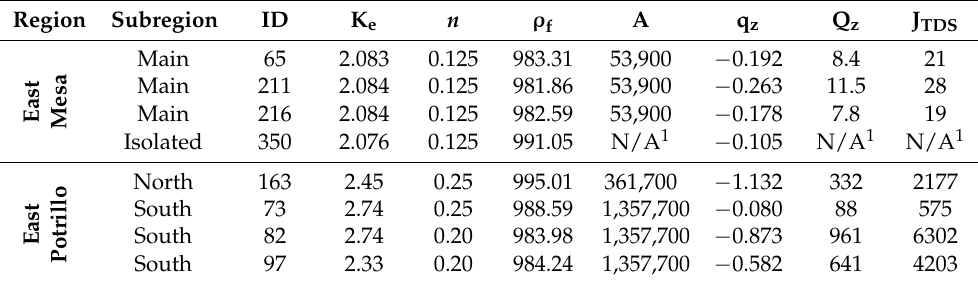
Table 1. Summary of flux estimates and input parameters used in modeling. Fluid specific heat was specified to be 4180 joules per kilogram per degree Celsius at all locations in the modeling. Modeled values for the thickness over which temperature data were analyzed (L) and best-fit Peclet numbers (Pe) are provided in Figure 6. Salinities of 1800 mg/L and 4823 mg/L were used to estimate salinity fluxes for the East Mesa and East Potrillo regions, respectively. Reported precision of tabulated values is for research reproducibility purposes and does not reflect value uncertainty. (Column headings and abbreviations: Region = region of upflow and associated geothermal system; Subregion = localized area within the larger upflow region; ID = temperature profile identification number from Pepin et al. (2019) [18]; K e = effective thermal conductivity in watts per meter per degree Celsius; n = porosity in dimensionless units; ρ f = fluid density in kilograms per cubic meter; A = upflow area in square meters; q z = vertical specific discharge in meters per year; Q z = volumetric vertical specific discharge in acre-feet per year; J TDS is salinity flux in tons of dissolved solids per year; N/A = not